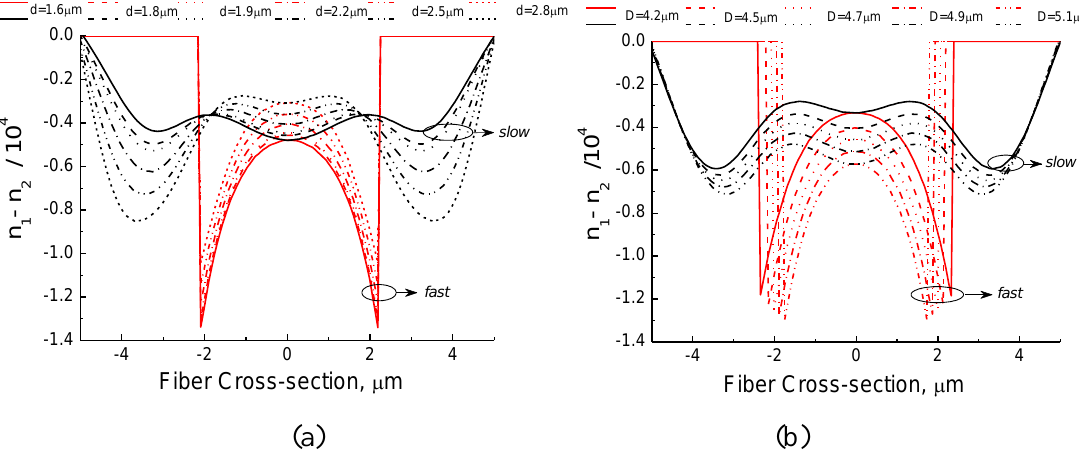
Figure 2. Difference between the refractive index components 𝑛 and fast axis [see Figure 1(b)] for a hydrostatic pressure of 34.4 MPa and λ = 1,500 nm as function of the (a) large hole diameter and (b) small hole